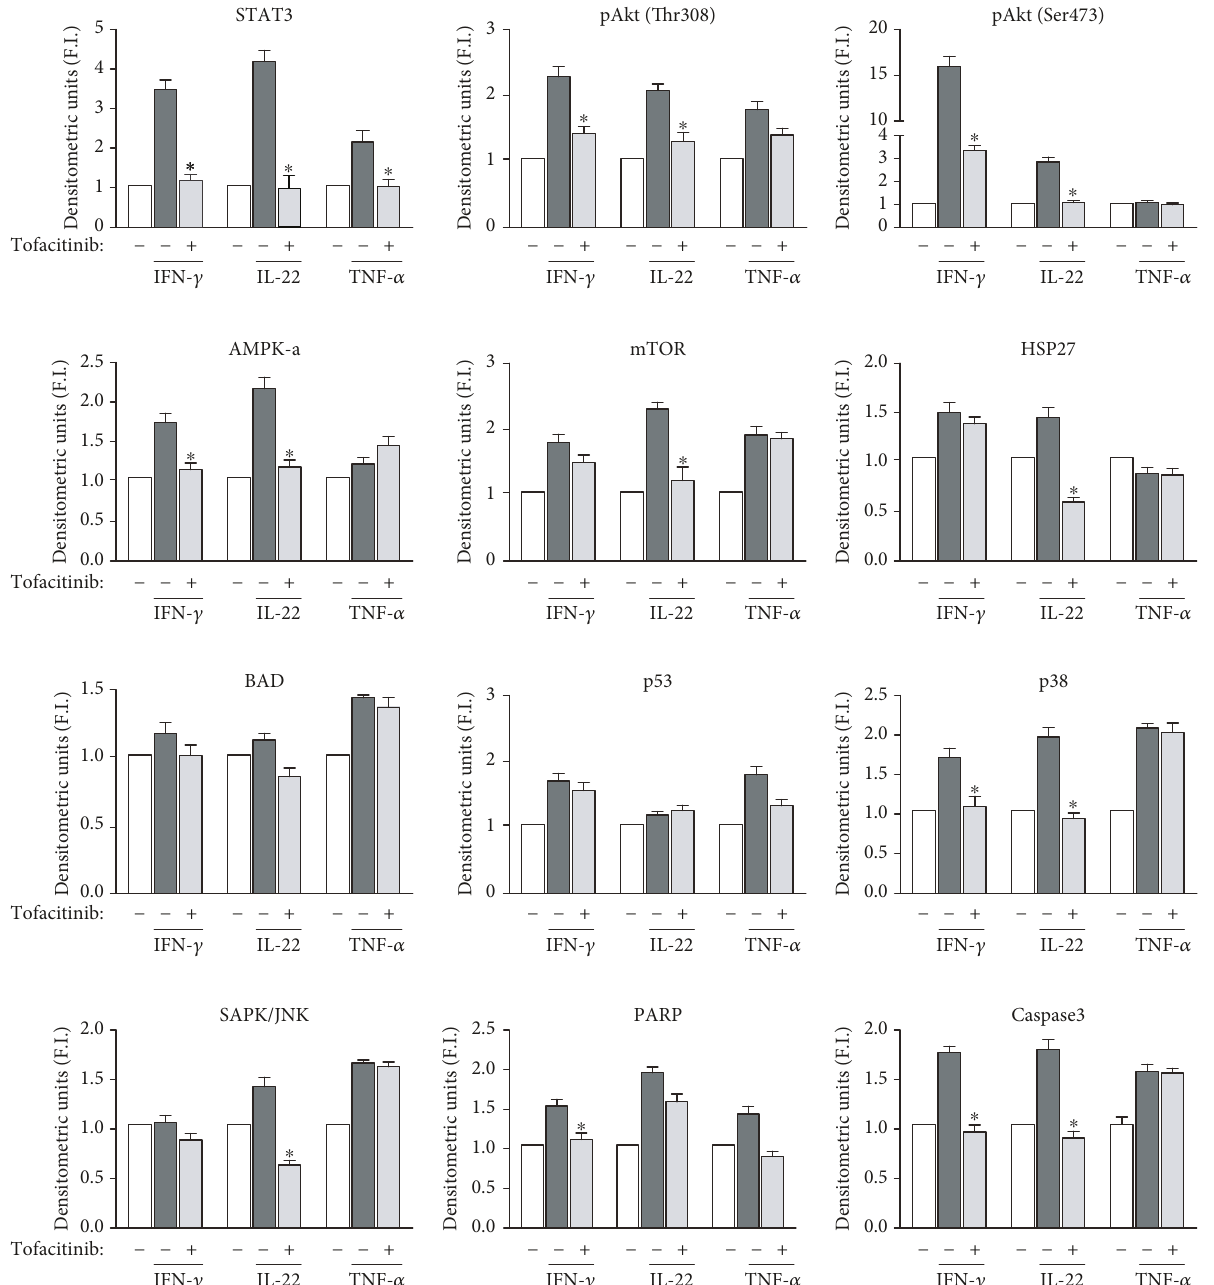
Figure 2: Tofacitinib regulates IFN- γ - and IL-22- but not TNF- α -induced signaling molecules in psoriatic keratinocytes. Protein extracts obtained from psoriatic keratinocytes pretreated with 5 μ M tofacitinib or vehicle alone and then stimulated or not with IFN- γ , IL-22, or TNF- α for 20 min were used on a PathScan intracellular signaling array, which allows the simultaneous detection of 18 signaling molecules when phosphorylated or cleaved. They include ERK1/2, STAT1, STAT3, Akt (Thr308 and Ser473 phosphorylation), AMPKa, mTOR, HSP27, Bad, p53, p38, SAPK/JNK, PARP, and caspase 3. Developed slides were acquired at ChemiDoc system. Graphs represent densitometric analyses of the indicated proteins. Data are expressed as mean ± SD fold induction (F.I.) calculated relatively to the untreated samples, which were given a value of 1. Protein panel was analysed in two assays with two di ff erent keratinocyte strains. Each value was normalized to an internal positive control. ∗ p < 0 05 for samples treated with tofacitinib vs. untreated, in the presence of